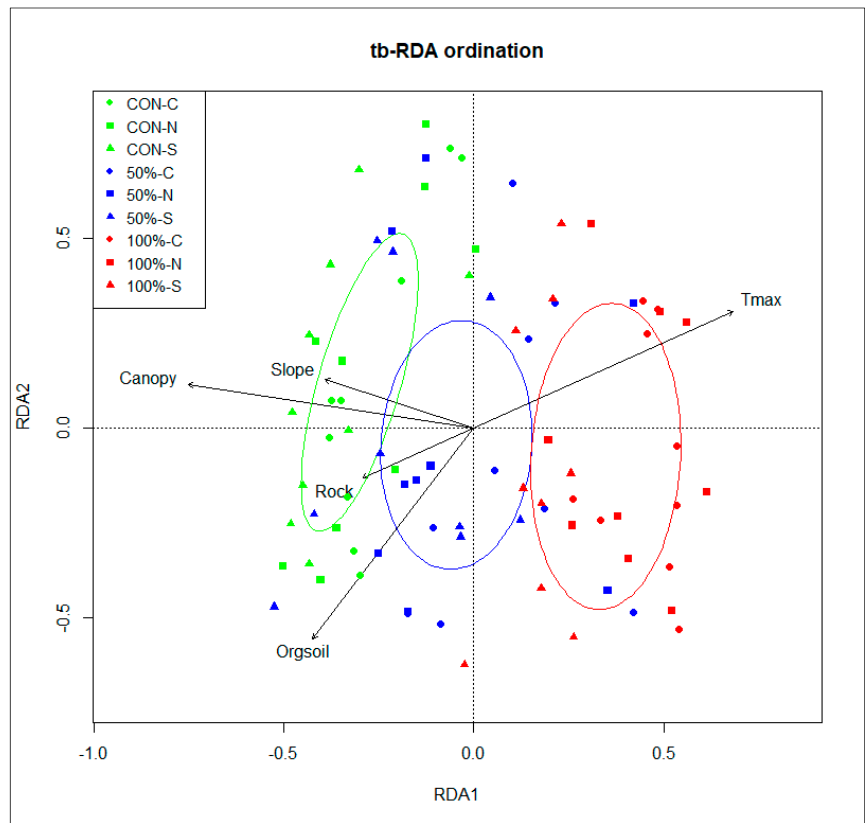
Figure 4. Transformation-based redundancy analysis (tb-RDA) of 81 post-treatment plots. Significant environmental variables of the final RDA model are shown with arrows (Canopy—canopy cover, Tmax—maximum daily temperature, Orgsoil—thickness of organic soil layer, Slope—slope inclination, Rock—percentage cover of rocks on the surface); the length of the arrow indicates the size effect. Symbols in green are for control plots (CON), blue for 50% cut, and red for 100% cut. The shape of the symbol denotes the within-sinkhole position (circle—centre, square—north, triangle—south). Confidence (95%) ellipses for the mean (i.e., group centroid of the management intensity category) are plotted.